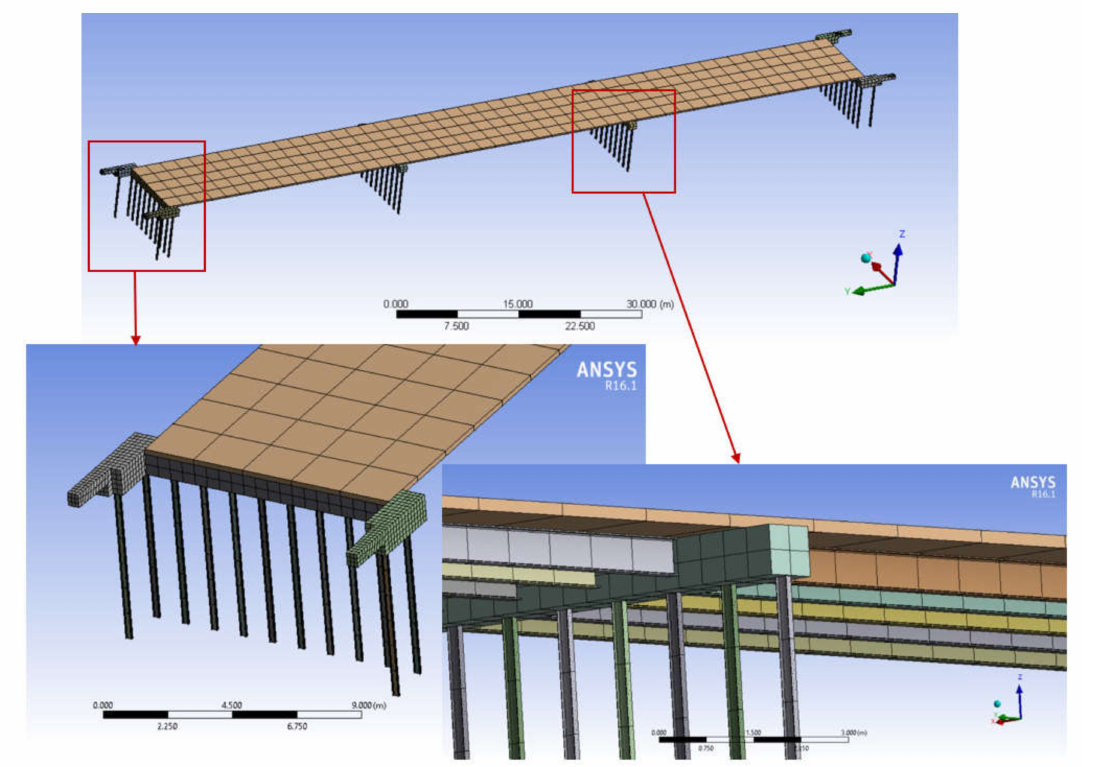
Figure 4. The FEM of the bridge and its components based on the results of sensitivity